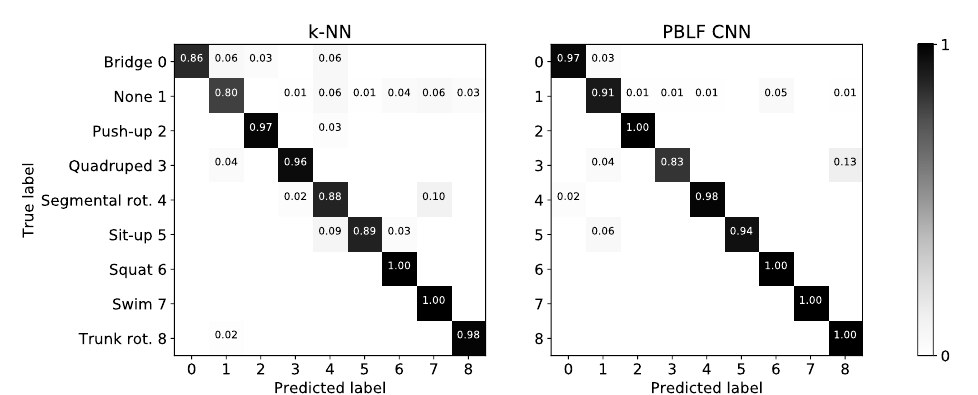
Figure A1. Confusion matrices of the models with the best performance on the test sets for the single-user evaluation is